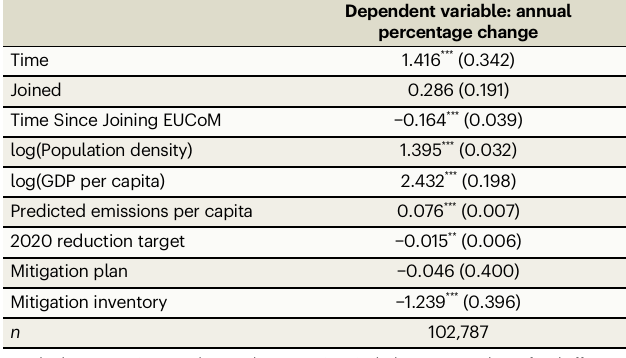
Table 2 | Results of interrupted time series analysis